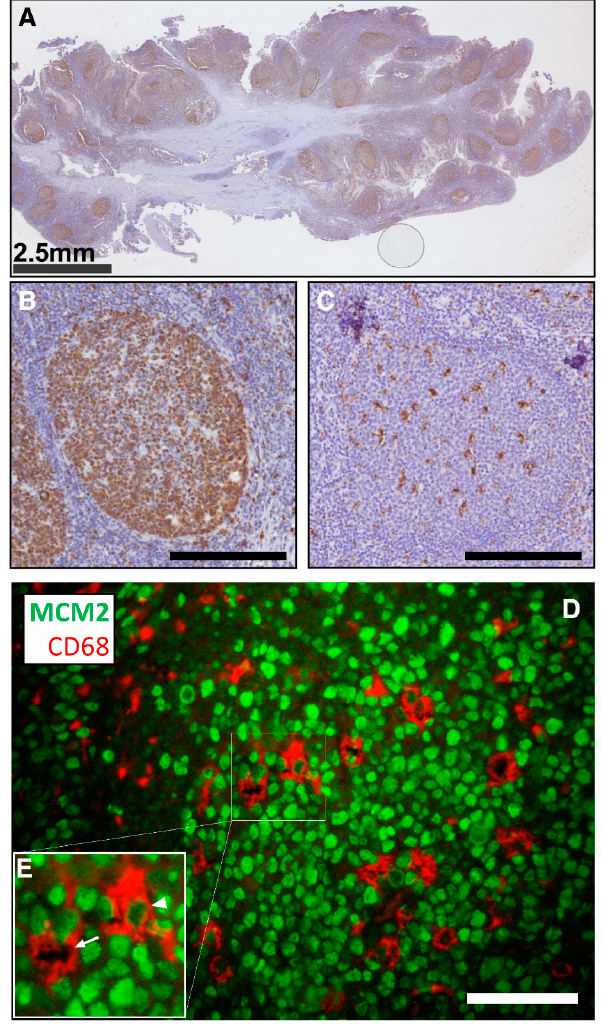
Figure 2. MCM2-expressing macrophages in human tonsils. ( A – C ) Immunohistochemistry of